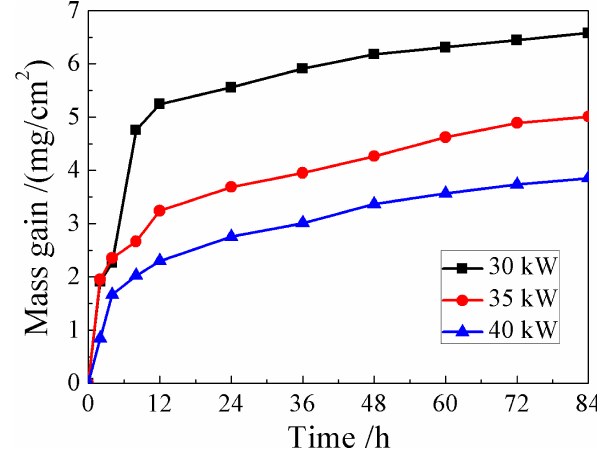
Figure 7: The mass gains of Fe-based amorphous coatings after oxidation at 700 ∘ C for 84 h.